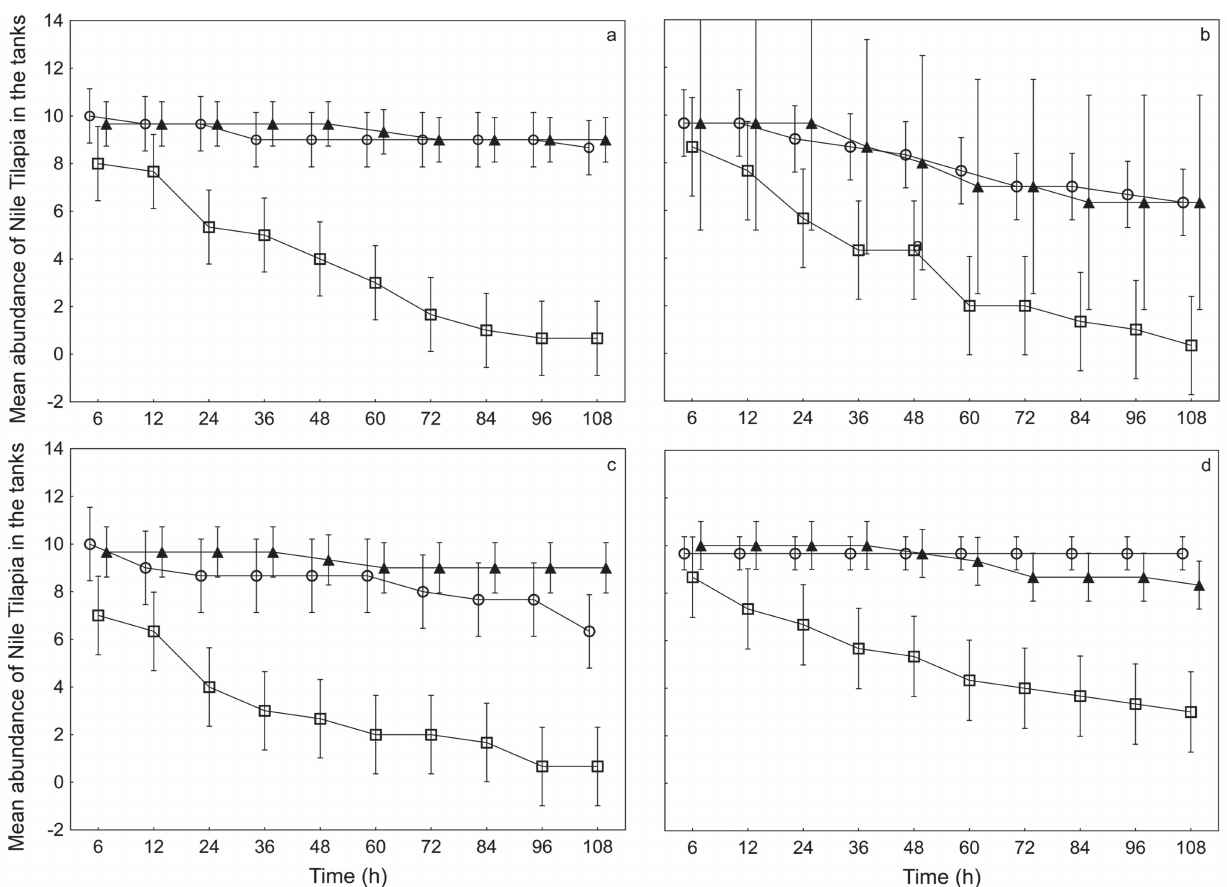
Fig. 4 . Temporal variation of predatory activity the experiment, in each treatment. Mean ± SD of Oreochromis niloticus survival in the tanks with Pseudoplatystoma corruscans (white circles), Salminus brasiliensis (white squares) and Brycon orbignyanus (black triangles). Levels of habitat complexity: a. 0%, b. 50%, c. 100% and d.